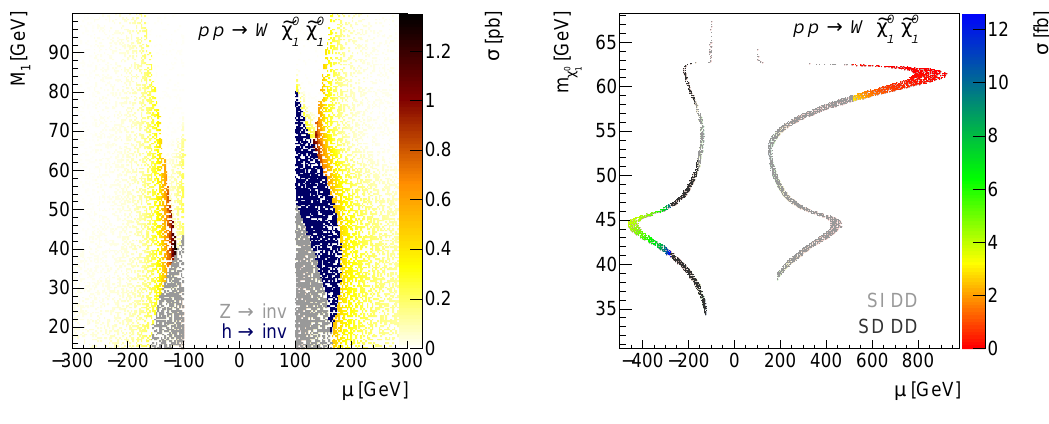
Figure 11: Cross section for the mono- W process in the µ − M fulfilling the chargino mass bound, shown with the limits on invisible Z and Higgs decays. Right: points also predicting the correct relic density, shown with DD